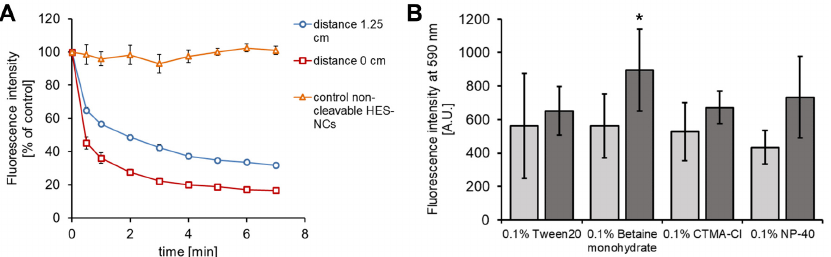
Figure 6. In ( A ) the relative fluorescence intensity of the model drug sulforhodamine 101 (SR101) to a non-irradiated control after irradiation of the HES-NCs 1144d with UVA from a distance of 1.25 cm (6.8 mW/cm 2 , blue, n = 6), 0 cm (30 mW/cm 2 , red, n = 8) and after irradiation of the non-cleavable HES-NCs 1144b (30 mW/cm 2 , orange, n = 4) is presented. ( B ) Release of SR101 as measured by fluorescence intensity of the supernatants (590 nm) after excitation at 485 nm without (light grey) and with cleavage of the HES-NCs (dark grey) showing a significant increase after irradiation of the HES-NC dispersion stabilized by 0.1% betaine monohydrate in EtOH (* = p < 0.05) as determined by one-tailed Student’s t -test for paired samples ( n = 3 to 4 samples). Presentation of mean values ± SEMs in both graphics.